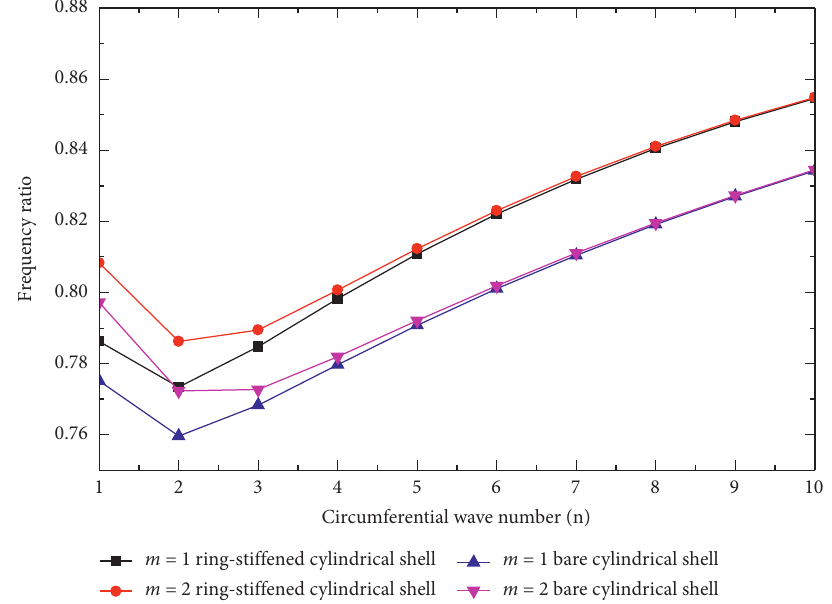
Figure 4: Variation curves of the ratio of coupling frequency of cylindrical shell.